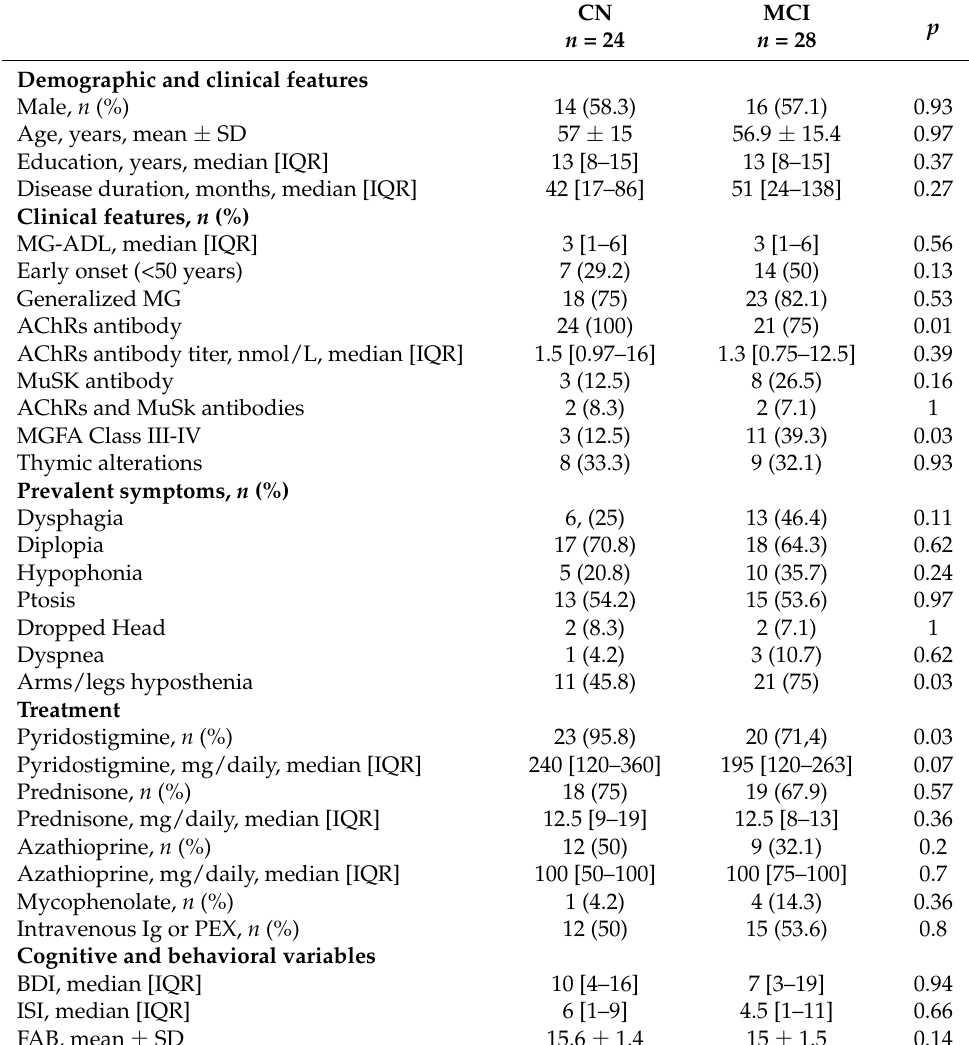
Table 1. Demographic, clinical, immunological, and cognitive/behavioral differences between CN and MCI